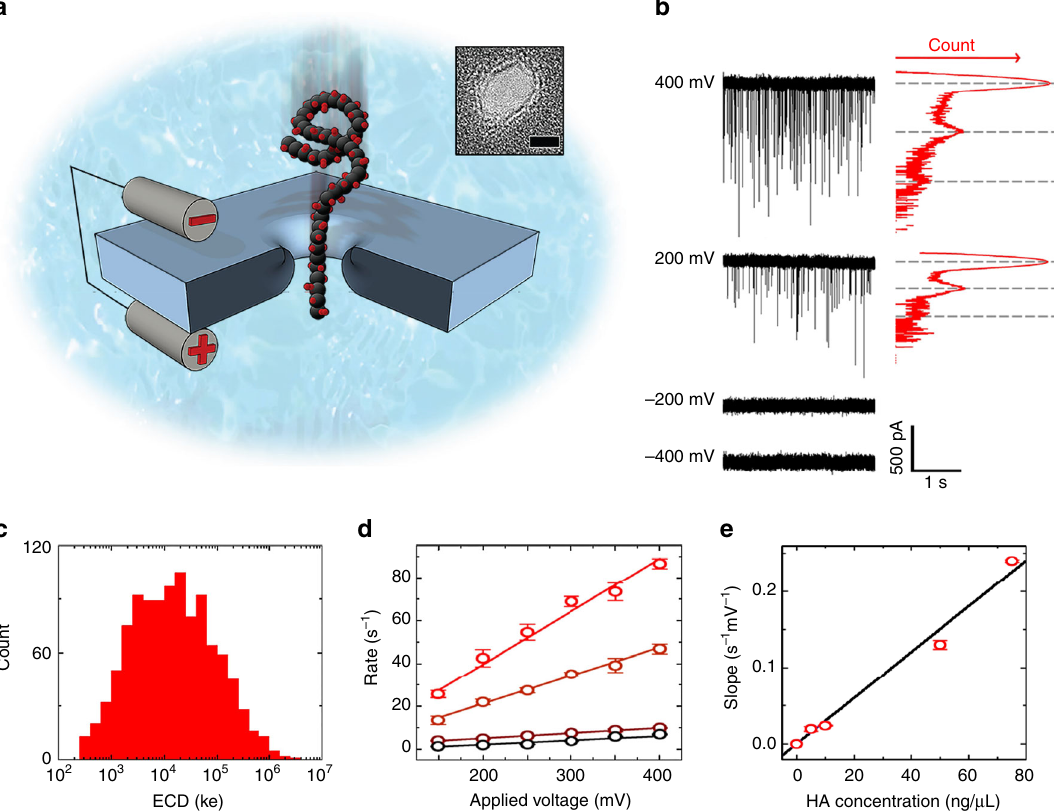
Fig. 1 SS-nanopore detection of polydisperse HA. a Schematic representation of electrophoretic translocation of HA through a SS-nanopore. Inset: transmission electromicrograph of a typical SS-nanopore fabricated with the same procedure used here. Scale bar, 5 nm. b Raw current traces obtained from a 6.5 nm SS-nanopore with HA introduced on one chamber ( cis- ) and indicated voltage applied to the other ( trans- ). Events were observed only toward positive bias. All-points histograms (red) show quantized current levels (dashed lines), indicating molecular folding. c Typical ECD histogram for polydisperse HA ( n = 1067) measured at 200 mV. d Voltage-dependent event rate for three concentrations of polydisperse HA ( t-b : 75, 50, 10, and 5 ng/ μ l). N -values (number of uninterrupted current traces) are listed in Supplementary Table 3 and error bars are standard deviations. Solid lines are linear fi ts to the data points. e Slopes from d showing a linear dependence (solid line) on net HA concentration. Error bars are errors of the fi